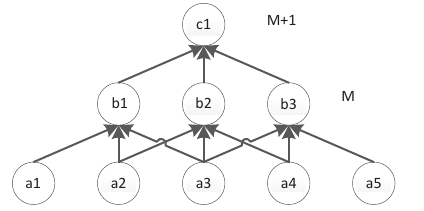
Figure 3. Deep neural network connection.